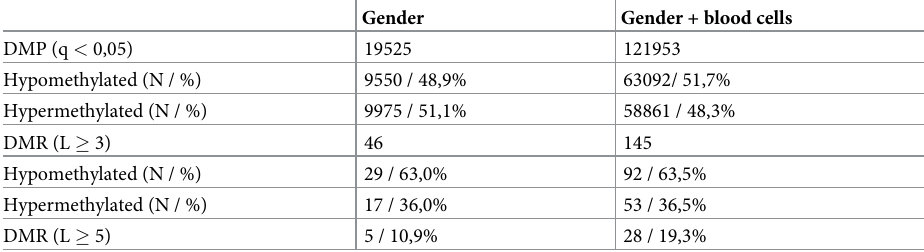
Table 1. Number of differentially methylated positions and regions between DS and